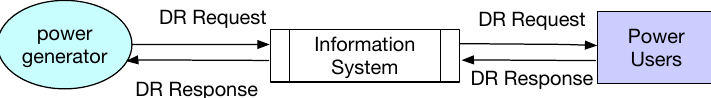
Figure 1. Demand response